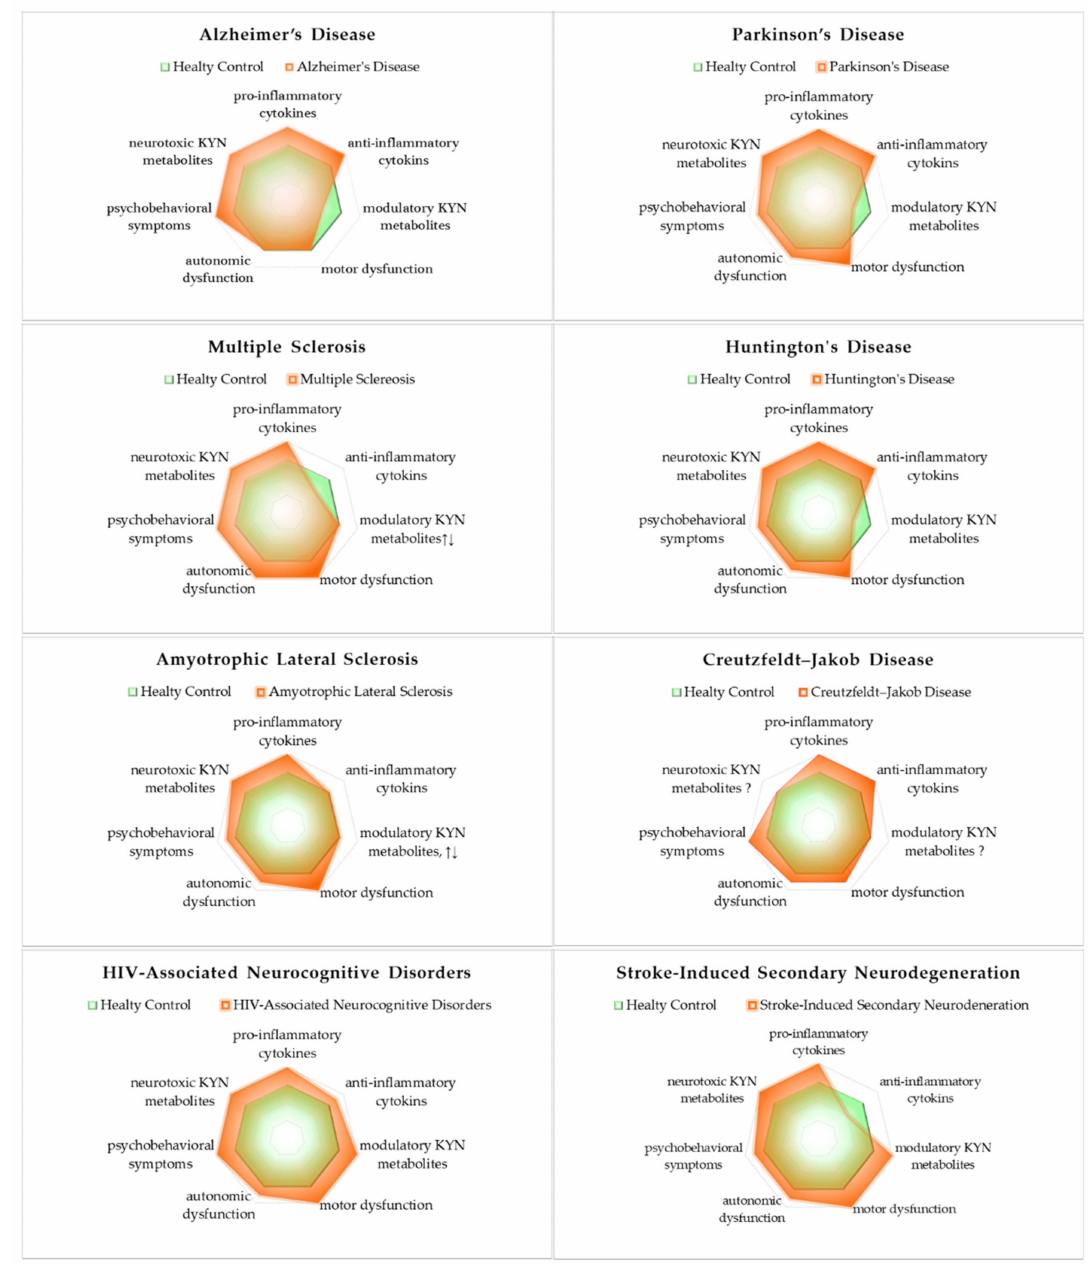
Figure 3. The status of inflammatory cytokines and kynurenines: signs and symptoms of neurodegenerative diseases. All neurodegenerative diseases significantly increased pro-inflammatory cytokines and neurotoxic cytokines. The involvement of three representative symptoms of neurological diseases is described in lower axes of the profiles: motor dysfunction, autonomic dysfunction, and psychobehavioral